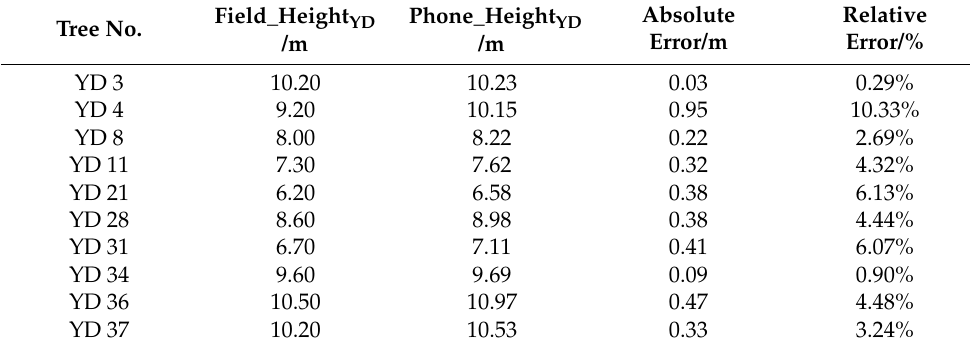
Table 3. The Field_Height YD , Phone_Height YD and error analysis. Tree